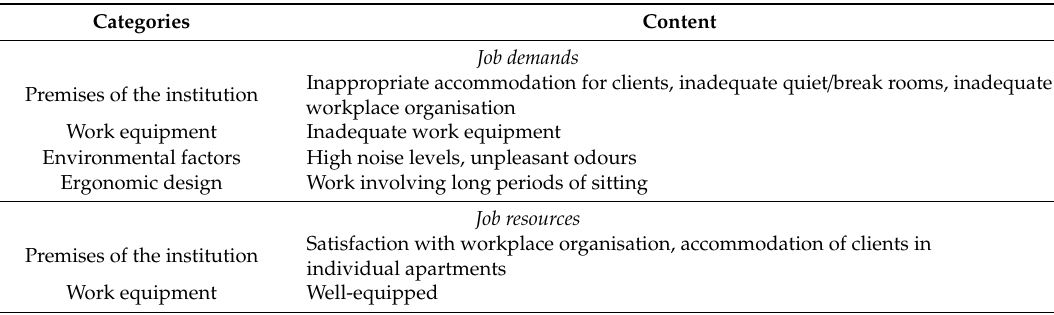
Table 5. Job demands and resources relating to work